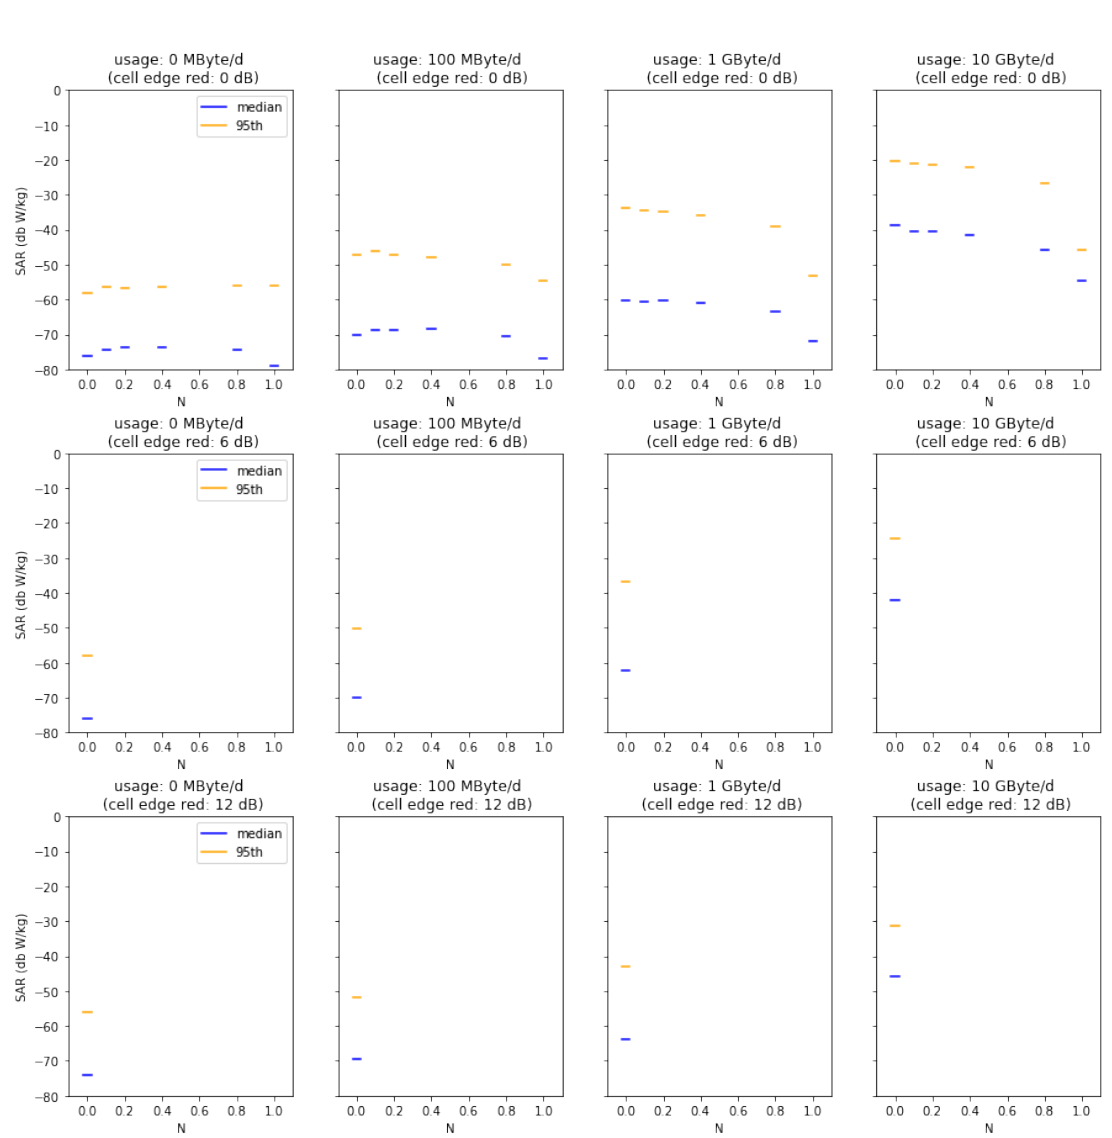
Figure A2. Median and 95th percentiles for varied usage, indoor coverage factor N , and cell size reductions in the suburban cell